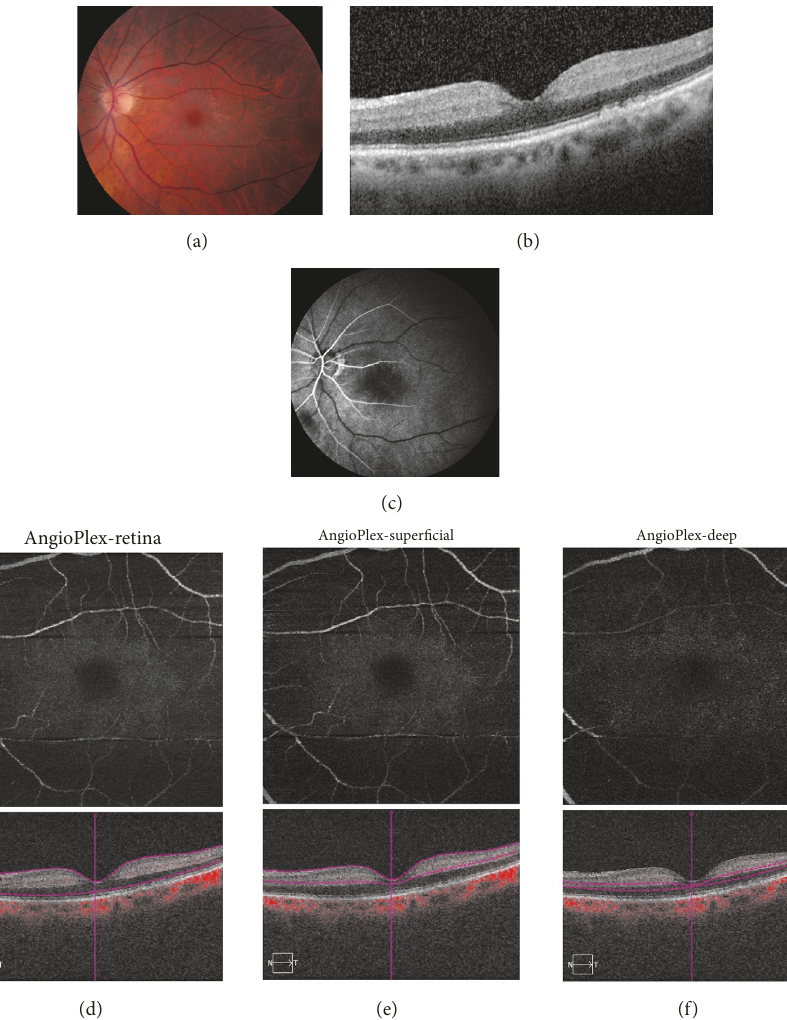
Figure 1: Acute central retinal artery occlusion, left eye. (a) Fundus photography reveals macular drusen and mild macular whitening with an early cherry red spot. (b) Spectral domain optical coherence tomography (SD-OCT) reveals thickening and hyperreflectivity of the inner retinal layers. (c) Fluorescein angiography (FA) at 26.58 seconds reveals delayed retinal perfusion. (d) Optical coherence tomography angiography (OCT-A) 6 × 6mm retina slab reveals absent flow similar to that seen on FA. (e) OCT-A 6 × 6mm superficial slab reveals absent flow. (f) OCT-A 6 × 6mm deep slab reveals absent